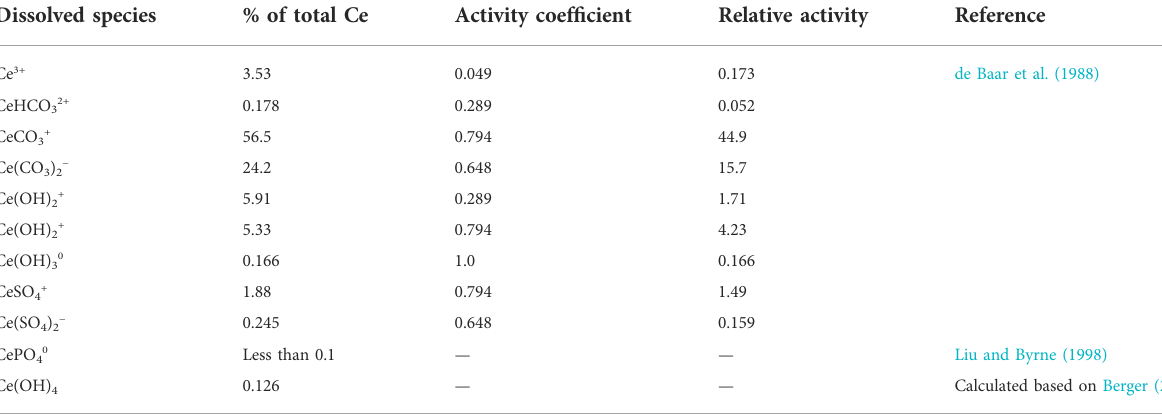
TABLE 1 The speciation of Ce in seawater (S=35, T=25 ° C, pH=8.2, Total CO 2 = 1.95 mmol/L [for data in de Baar et al. (1988)].